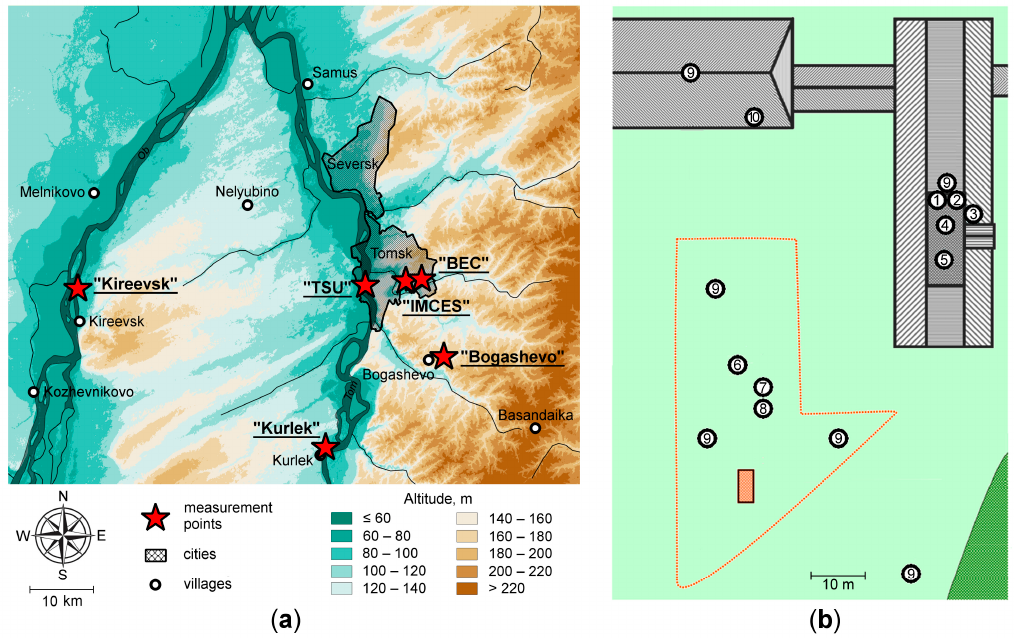
Figure 1. Location of the GO IMCES and remote stations ( a ). Layout equipment plan at base station, the GO IMCES ( b ) 1 is the weather transmitter WXT520; 2 is the anemorumbometer M-63; 3 is the polar electrical conductivity meter “Electroconductivity-2”; 4 depicts sensors of temperature, humidity and pressure; 5 depicts the pyranometer CM11, and the radiometers NILU-UV-6T and M-124; 6 depicts the electric field mill meters “Field-2” and CS110; 7 is the optical rain gauge OPTIOS; 8 is the Tretyakov rain gauge; 9 depicts the automatic weather stations AMK-03; 10 are the integrating nephelometer, the aerodynamic particle sizer and the scanning mobility particle sizer.